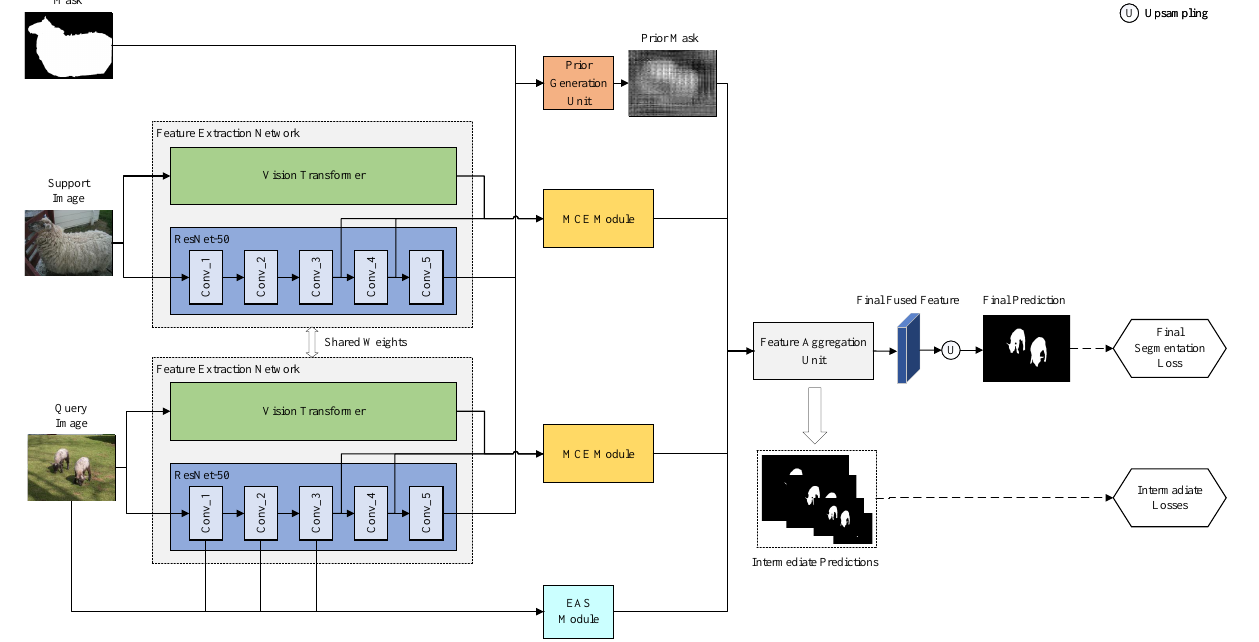
Figure 2. Overall network framework of the proposed MCEENet. The query image and support image are fed into the feature extraction network (weight-shared) to extract middle-level features (inside the larger gray dotted box), green/blue represent ViT/Resnet-50 feature extraction network. The extracted middle-level features then enhanced by the MCE module. The prior generation unit generates the prior mask of the query image using support image, support mask, and query